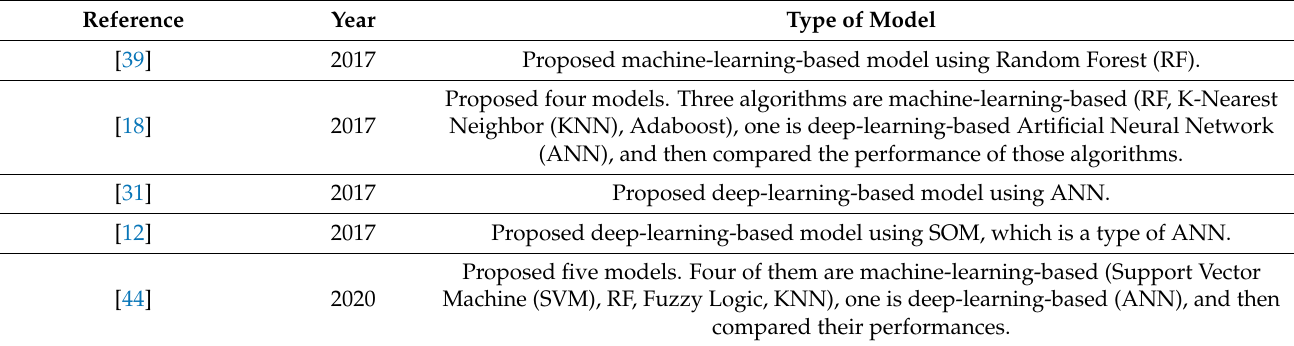
Table 2. Previous methods used in recognition systems.